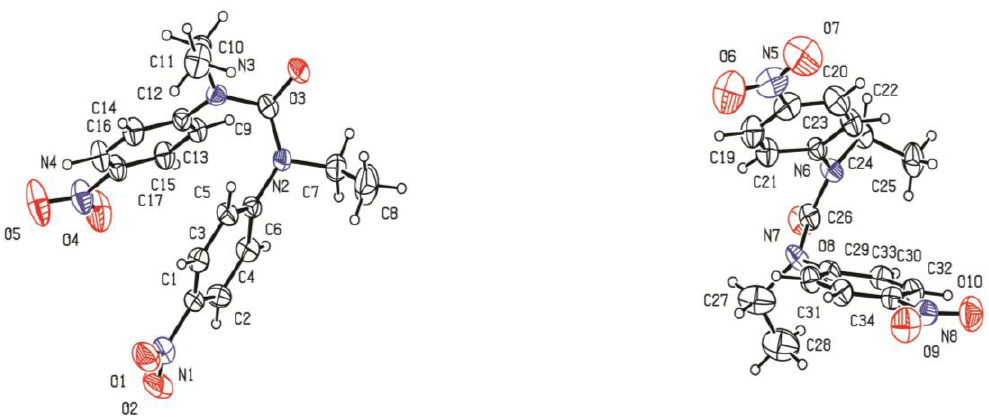
Figure 3. Unit cell of C 17 H 18 N 4 O 5 .